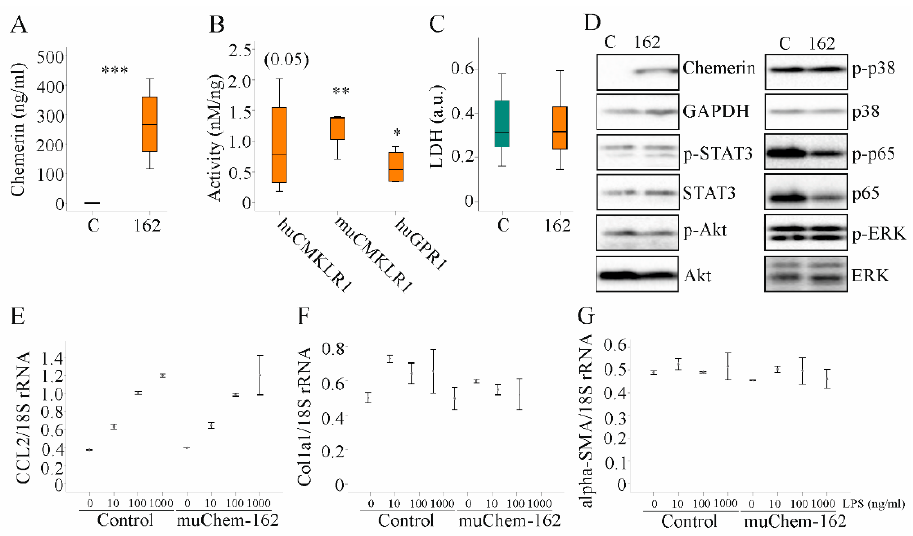
Figure 5. Overexpression of muChem-162 had no effect on inflammatory and profibrotic molecules in Hepa1–6 cells: ( A ) Chemerin in the supernatant of Hepa1–6 cells transfected with the insert-less (C) or muChem-162-coding plasmids (162) ( n = 4); ( B ) Activation of human and murine chemokine-like receptor 1 (CMKLR1) and human G protein-coupled receptor 1 (GPR1) by media of the recombinant cells relative to chemerin protein levels. Control-transfected cell media were not active ( n = 4); ( C ) Lactate dehydrogenase (LDH) in the cell media ( n = 13); ( D ) Immunoblot of chemerin, signal transducer and activator of transcription 3 (STAT3), Akt, p38 kinase, p65, and extracellular-signal regulated kinase (ERK) and their phosphorylated (p-) forms; ( E ) CCL2 mRNA in Hepa1–6 cells transfected with the control vector or the plasmid to express muChem-162, and cells were incubated with increasing concentrations of LPS ( n = 2); ( F ) Collagen (Col)1a1 mRNA in these cells ( n = 2); ( G ) Alpha-smooth muscle actin (alpha-SMA) mRNA in these cells ( n = 2). In ( E – G ), the mean values +/ − standard deviations are shown. Student’s t-test, * p < 0.05, ** p < 0.01, *** p < 0.001.